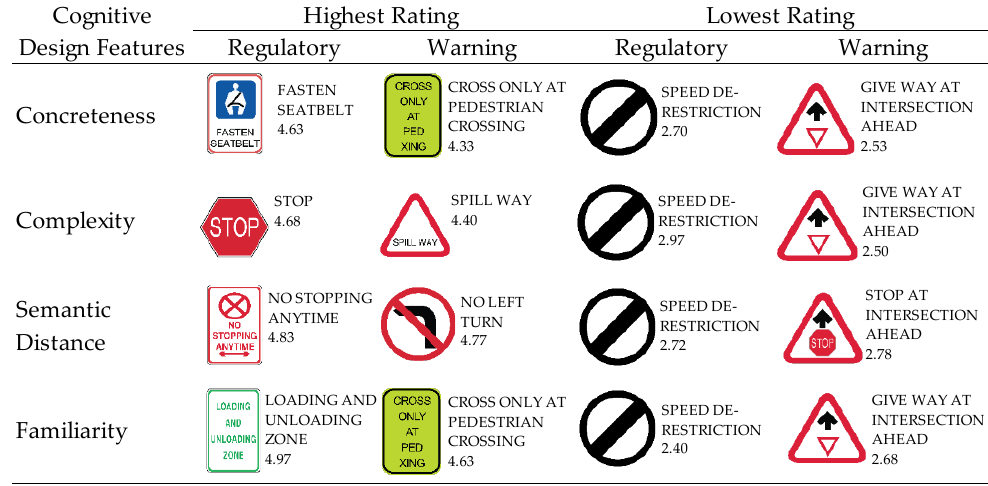
Table 11. The Highest and Lowest Ratings Based on Cognitive Design Features.